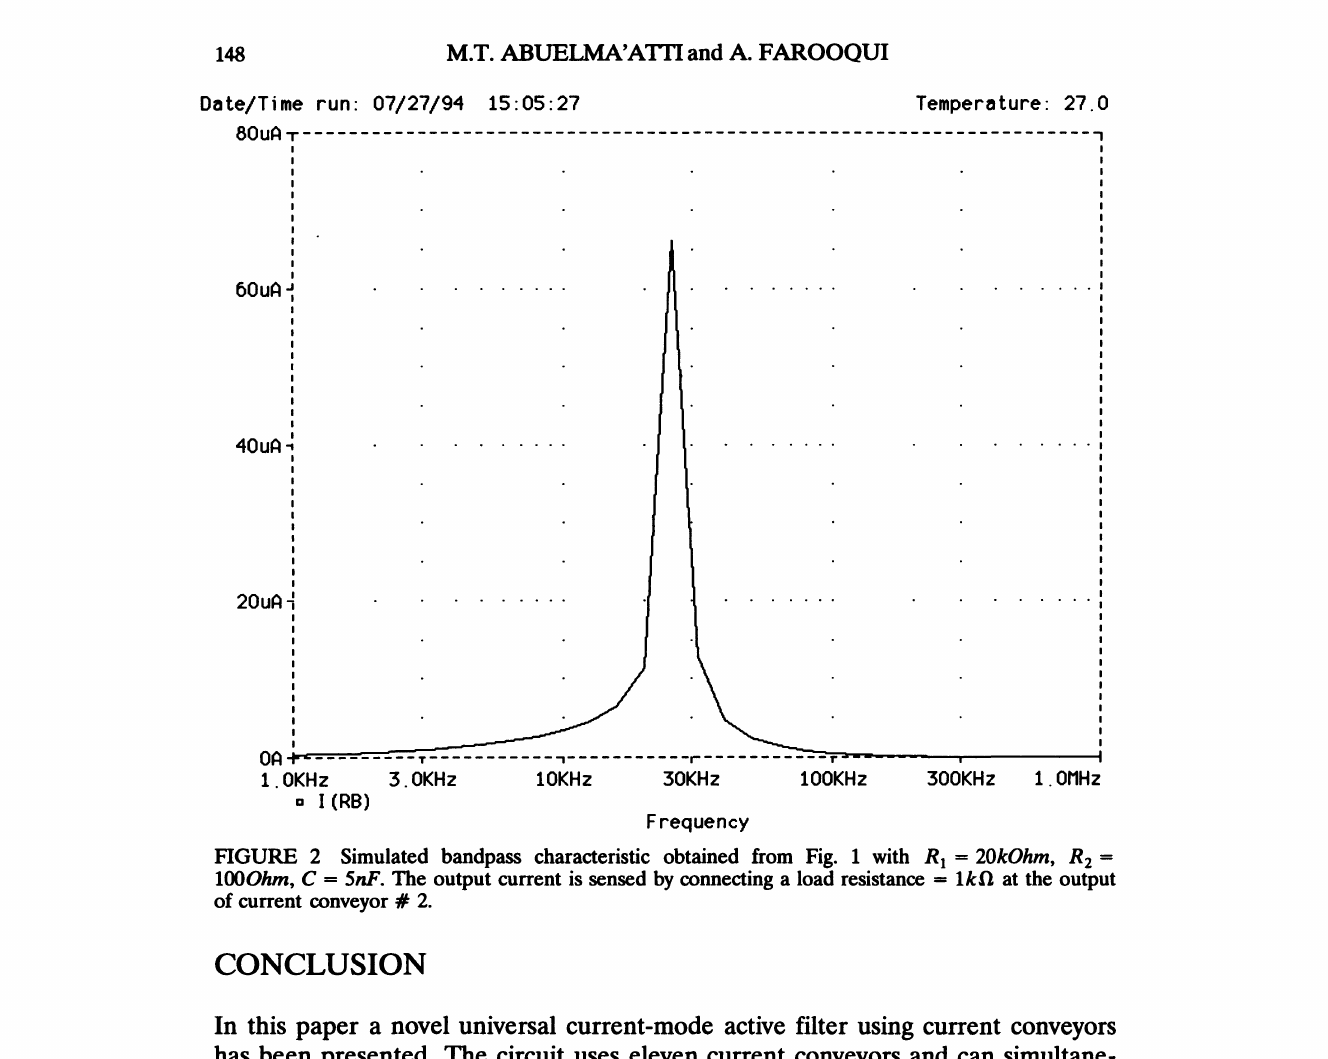
FIGURE 2 Simulated bandpass characteristic obtained from Fig. 1 with R 20kOhm, R lO00hm, C 5nF. The output current is sensed by connecting a load resistance lk at the output of current conveyor #